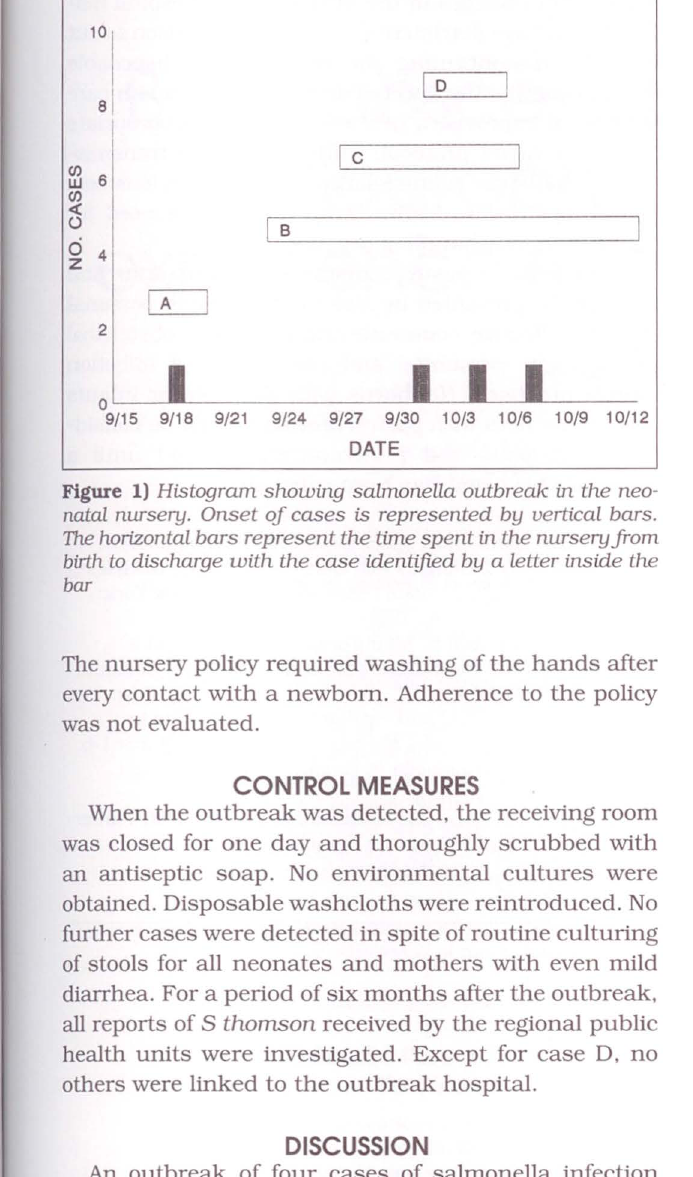
Figure 1) Histogram showing salmonella outbreak in the neo natal nursery. Onset of cases is represented by vertical bars. The horizontal bars represent the time spent in the nursery .from birlh to discharge with the case identified by a letter inside